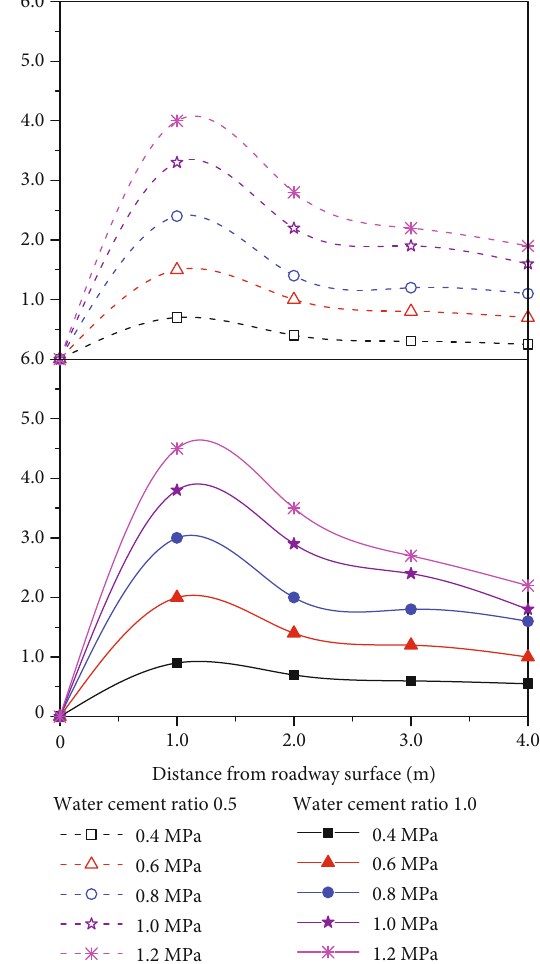
Figure 5: Grouting pressure distribution